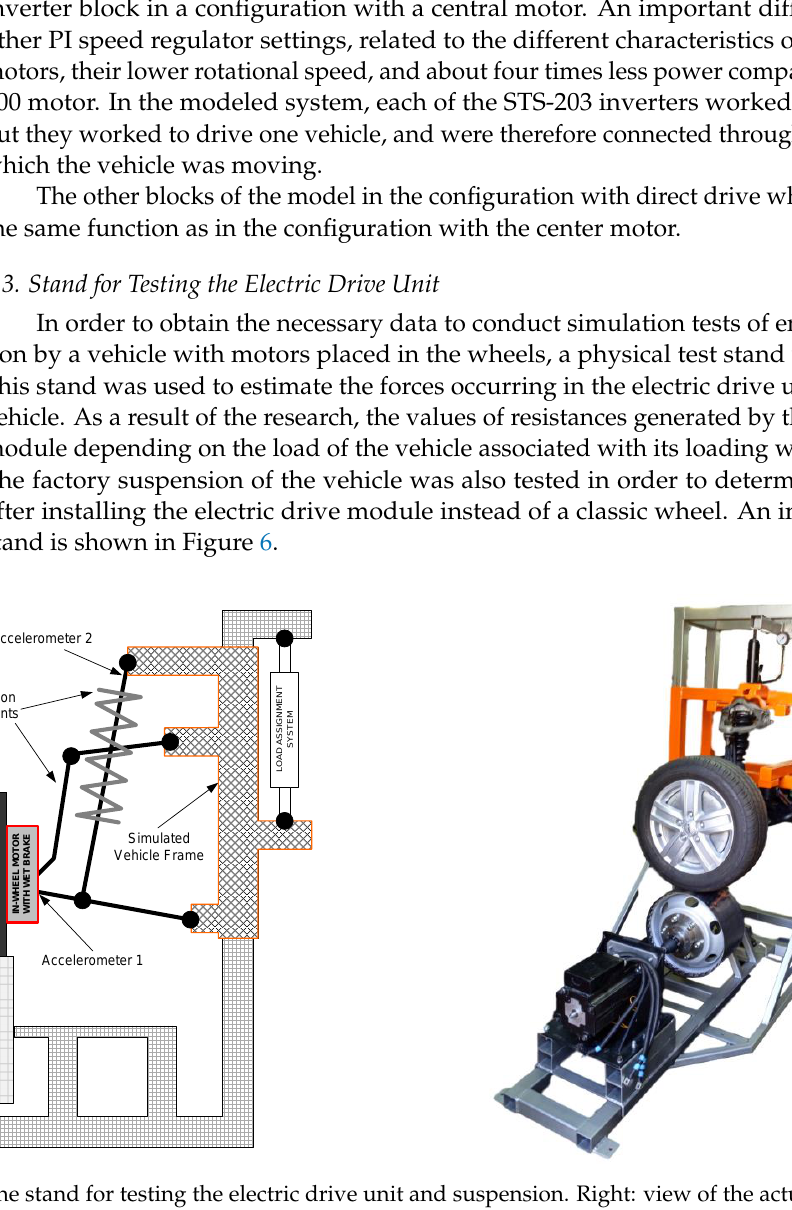
Figure 6. Construction of the stand for testing the electric drive unit and suspension. Right: view of the actual stand.